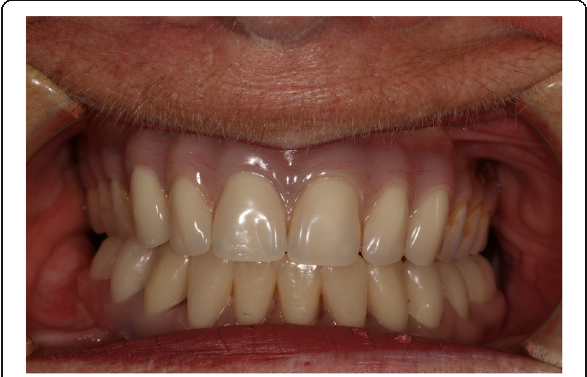
Fig. 6 Mandibular implant-retained wax try-in stage and pre-existing maxillary complete